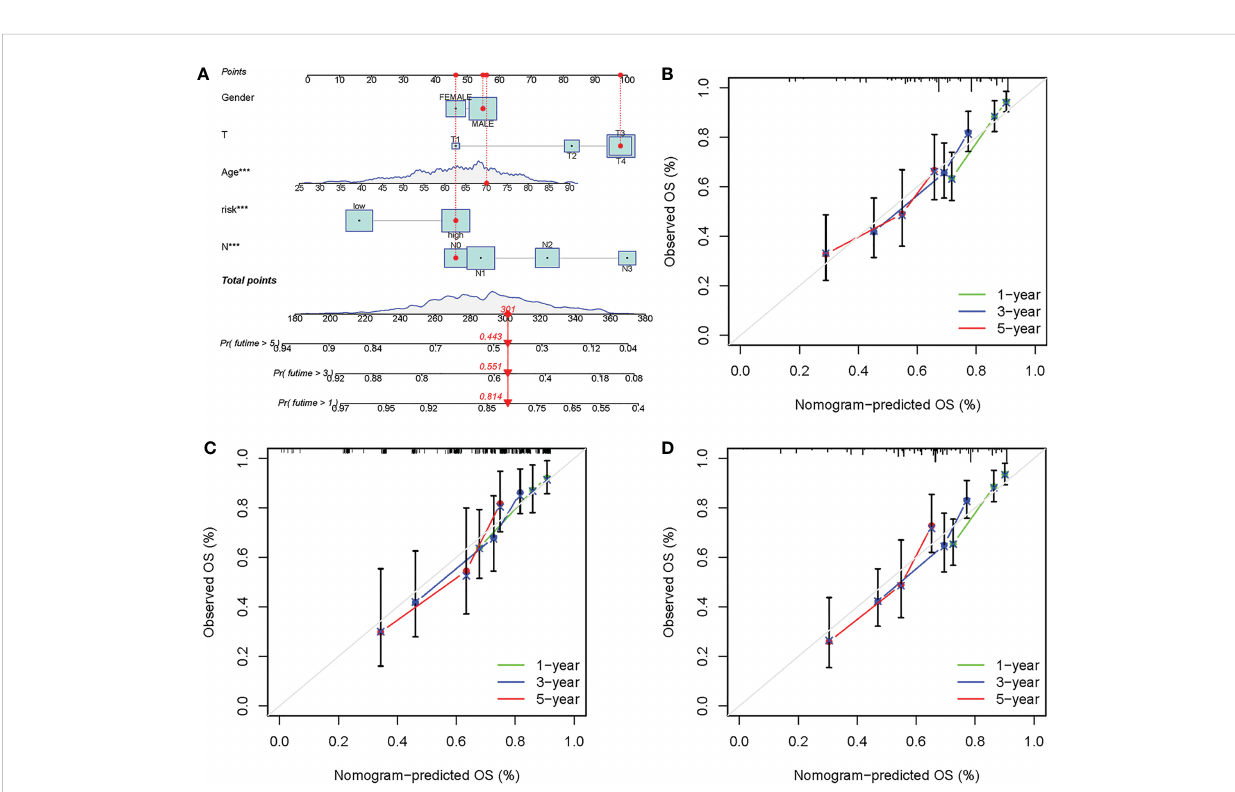
FIGURE 8 Development of a prognostic nomogram based on the risk score. (A) Development of the nomogram based on clinicopathological parameters and risk score in the training cohort. Calibration curves at 1-, 3- and 5-year in the (B) ICGC cohort, (C) training cohort, and (D) internal validation cohort. *** P -value < 0.001.